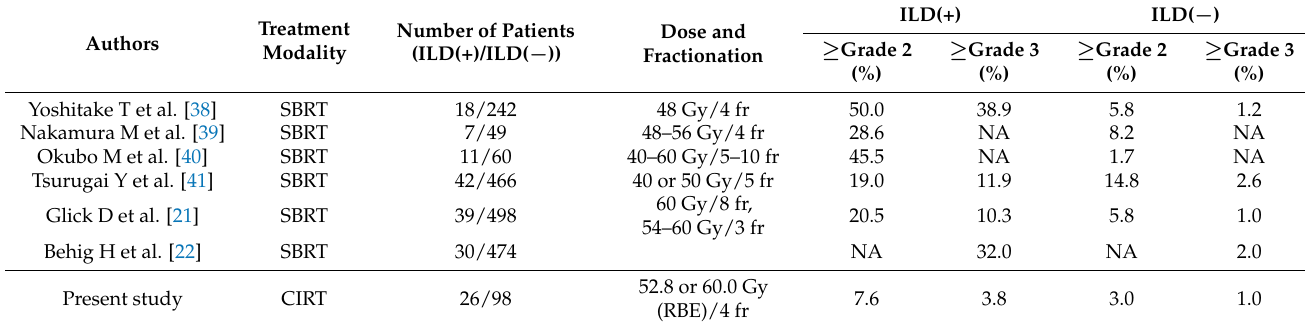
Table 4. Incidence of radiation pneumonitis (Grade 2 or worse) in patients with or without interstitial pneumonitis.